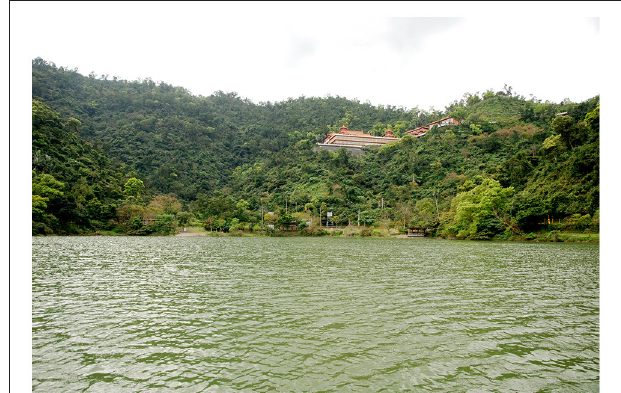
FIGURE 6 | View of San-Chin-Gong Temple took from the location of MHL-11-02. As the headquarter of the Taoism Association in Taiwan,